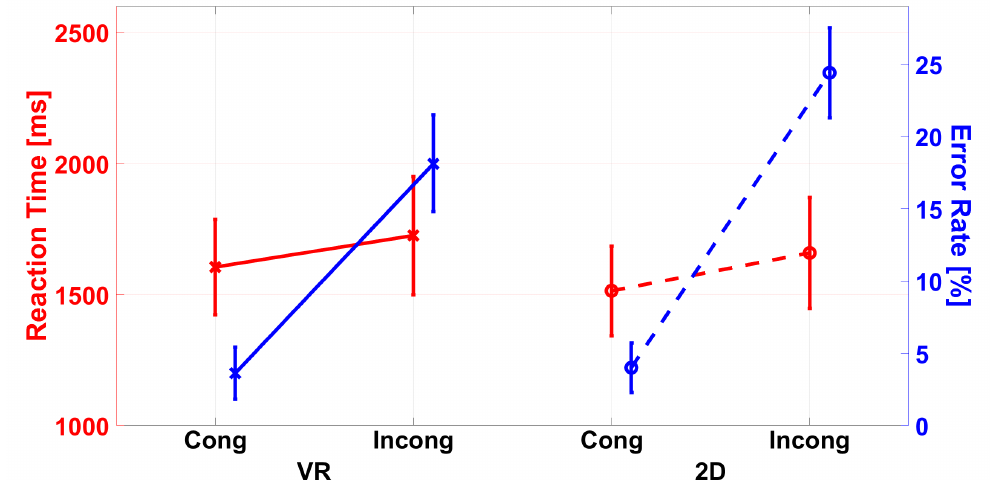
Figure 8. Difference in reaction times (RT, red in ms) and error rates (ER, blue in %) between the 2D and VR group for the congruency. In the reaction time and error rates, the ANOVA revealed a main effect of congruency, indicating lower RTs and ERs in congruent trials. For ERs, the ANOVA also revealed an interaction with the group indicating lower ERs for the VR than the 2D group in incongruent trials. The error bars represent the standard